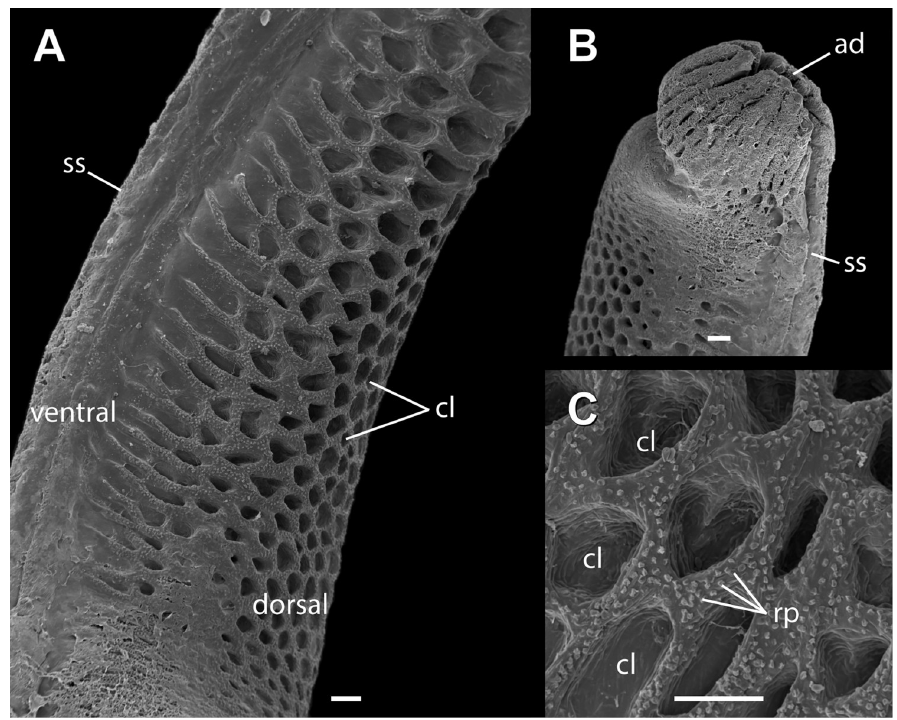
Fig 4. Adult hemipenis of Tropidurus torquatus under SEM analysis. (A) calyces, (B) apical disc and (C) reduced papilla. Figure legends: ad, apical disc; cl, calyces; rp, reduced papilla; ss, spermatic sulcus. Scale bar: 100 μ m.